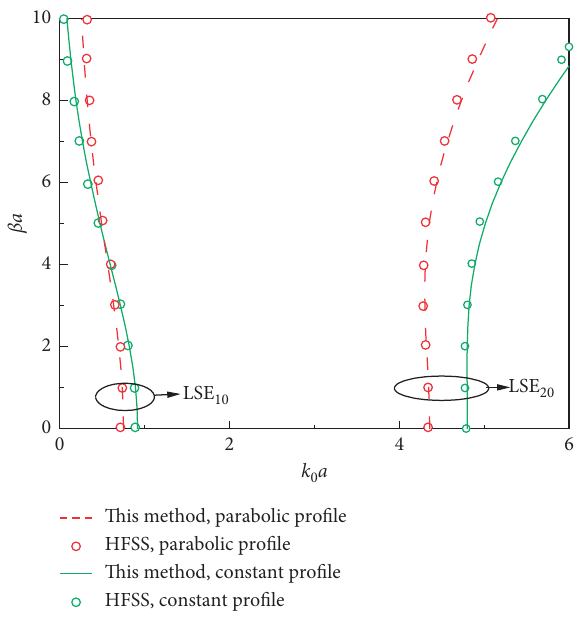
Figure 10: Dispersion diagrams of a rectangular waveguide for constant and parabolic profile functions; the curves illustrated with green or red lines are obtained with the proposed technique; curves with green or red circles are obtained with HFSS simulation. regions, and convergence to 0.1% on Δ β is achieved in 7 steps (using the eigenmode simulation).